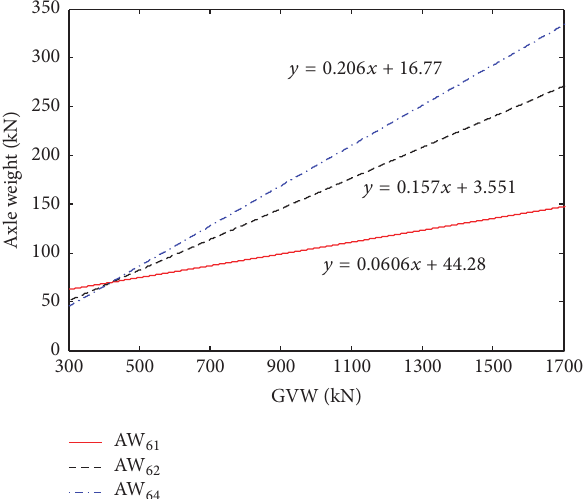
Figure 2: Fitted functions of axle weight distributions of the 6-axle truck.